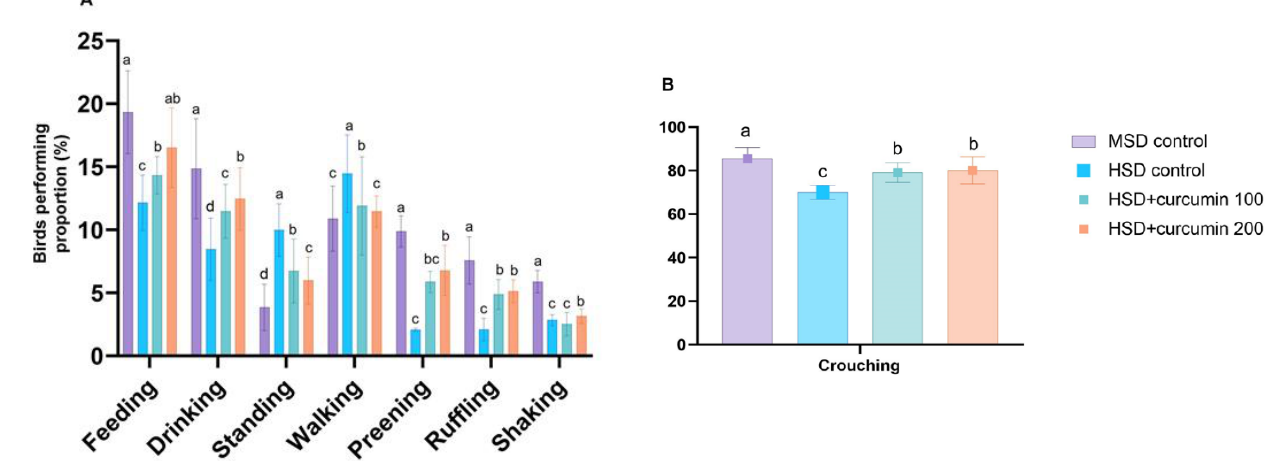
Figure 1. Effect of curcumin on the proportion (%) of birds performing different behavioural patterns ( A ). Feeding, Drinking, Standing, Walking, Preening, Ruffling and Shaking. ( B ). Crouching reared under high stocking density. The data shown are the mean and standard deviation. a–d Means bearing different superscript letters within the same row are significantly different ( p < 0.05). MSD = low stocking density, HSD = high stocking density. Table 5. Effect of curcumin on haematological parameters of broilers reared under high stocking